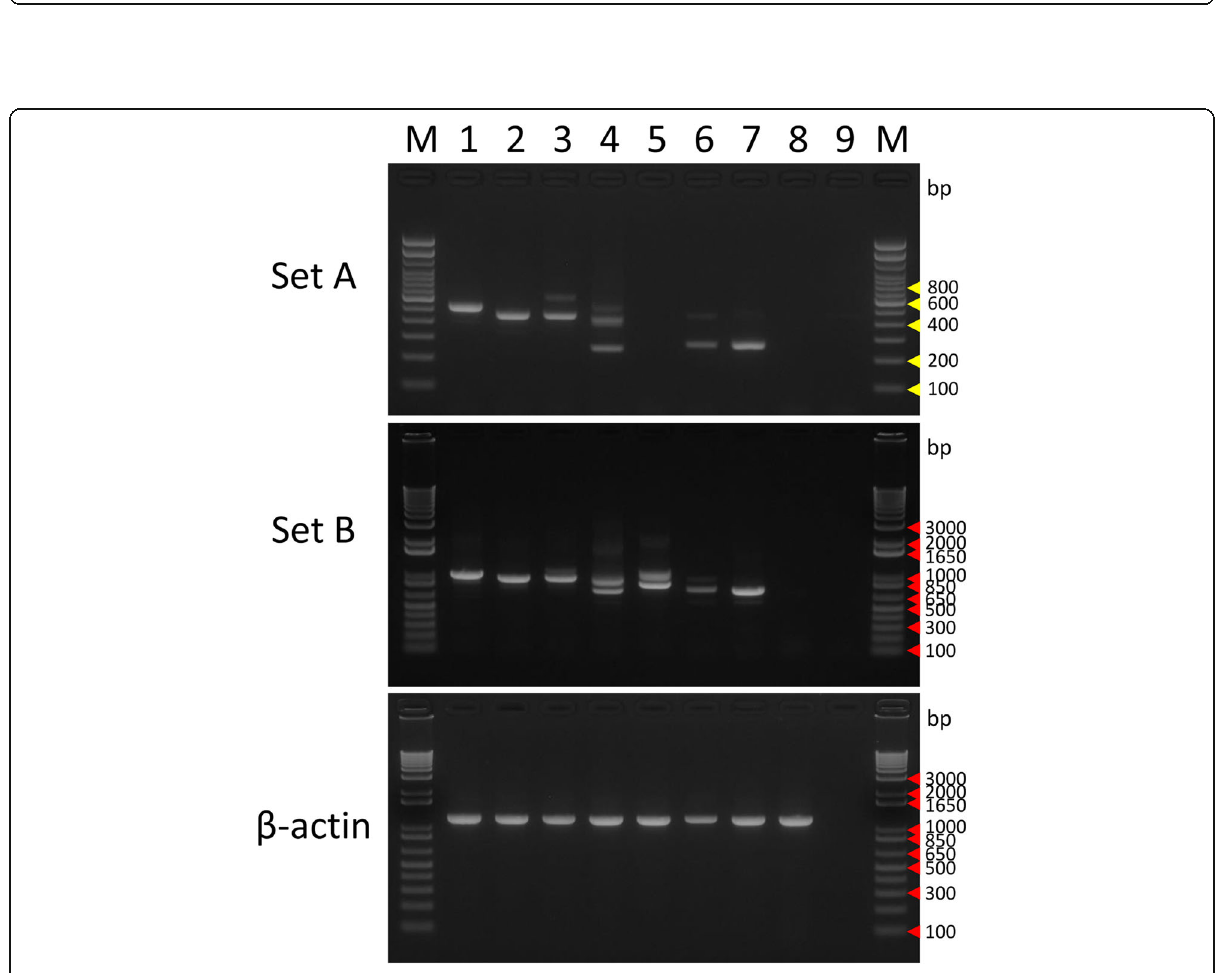
Fig. 3 Multiplex RT – PCR in tumor samples. Multiplex (top and middle panels) and control (bottom panel) RT – PCR were performed in six tumor samples. Lane M: Trackit 100-bp ladder marker (top panel) or Trackit 1-kbp plus ladder (middle and bottom panels). Molecular sizes are indicated in the right with yellow arrowheads (a) and red arrowheads (b), respectively.; lane 1: NCR-EW2 cDNA for the positive control; lane 2: tumor 1; lane 3: tumor 2; lane 4: tumor 3; lane 5: tumor 4; lane 6: tumor 5; lane 7: tumor 6; lane 8: NRS-1 cDNA for the negative control; lane 9: no template